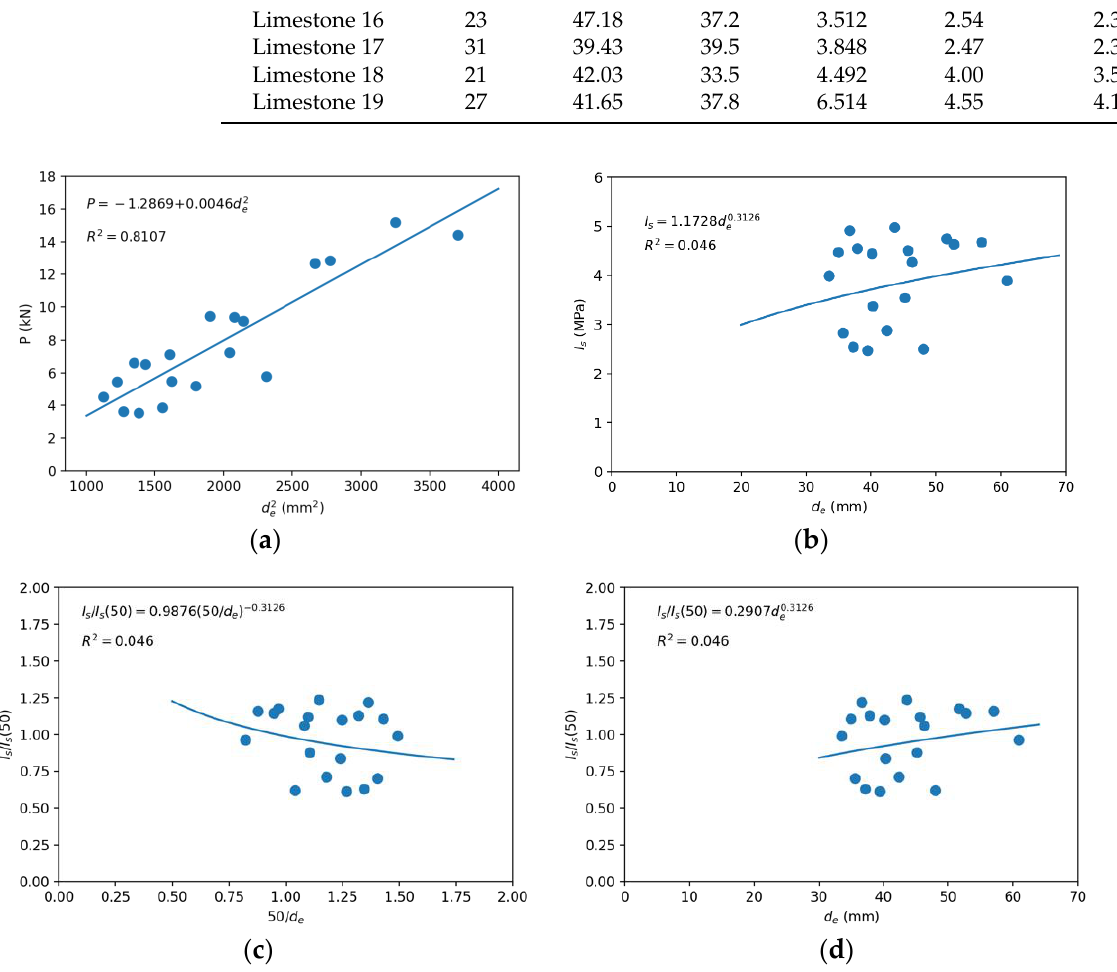
Figure 2. Scale effect for the point load index of the limestone: ( a ) quadratic fit of P–d e and ( b ) potential fit of I s – d e , to determine the referential value of I s (50) ; ( c ) potential fit of I s / I s (50) – 50/ d e and ( d ) I s / I s (50) – d e to determine k 2 .